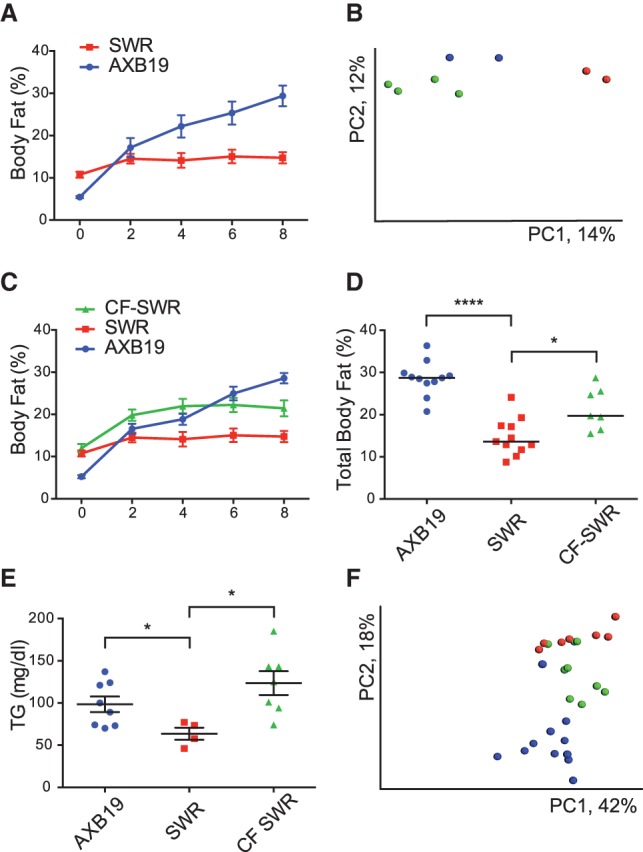
Cross-fostering influences dietary responsiveness. (A) Body fat increase in SWR and A×B19 strains during 8 wk of the HF/HS diet. (B) Principal Coordinate Analysis (PCoA) of unweighted UniFrac distances for fecal samples after cross-fostering newborn SWR and A×B19 pups between parents (blue = A×B19 mothers, red = SWR mothers, and green = cross-fostered SWR pups), P < 0.05 for unweighted UniFrac using Student's t-test with 1000 Monte Carlo simulations. (C) Body fat changes after cross-fostering SWR pups with A×B19 mother (CF-SWR) compared to SWR and A×B19 controls. (D) Total body fat percentage after 8 wk of HF/HS feeding. (E) Plasma triglycerides (TG) levels. (F) PCoA of unweighted UniFrac distances for cecum samples after 8 wk of the HF/HS diet (blue = A×B19, red = SWR, green = cross-fostered SWR). Significant differences: (*) P < 0.05, (****) P < 0.0001, according to unpaired two-tailed Student's t-test. See also Supplemental Figure 2.